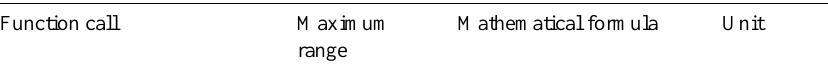
Table 2. Definitions of the primary functions used in the determination of all other functions in the library. Maximum ranges given are necessary conditions for validity. The relations to the sufficient conditions established by the foundational publications are discussed in the main text. The letters f and g are used to indicate Helmholtz and Gibbs functions, respectively. The letters l , m and n indicate the order of derivatives with respect to S , T , P or ρ